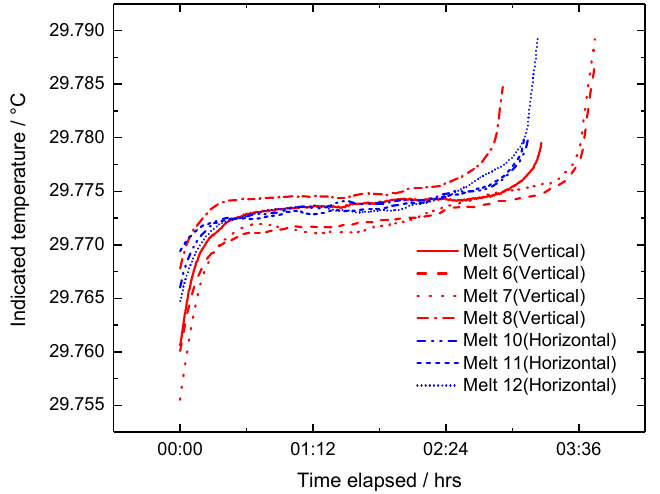
Figure 3. Repeatability of the melting plateaux for different orientations of the cell; ‘vertical’ means upright.